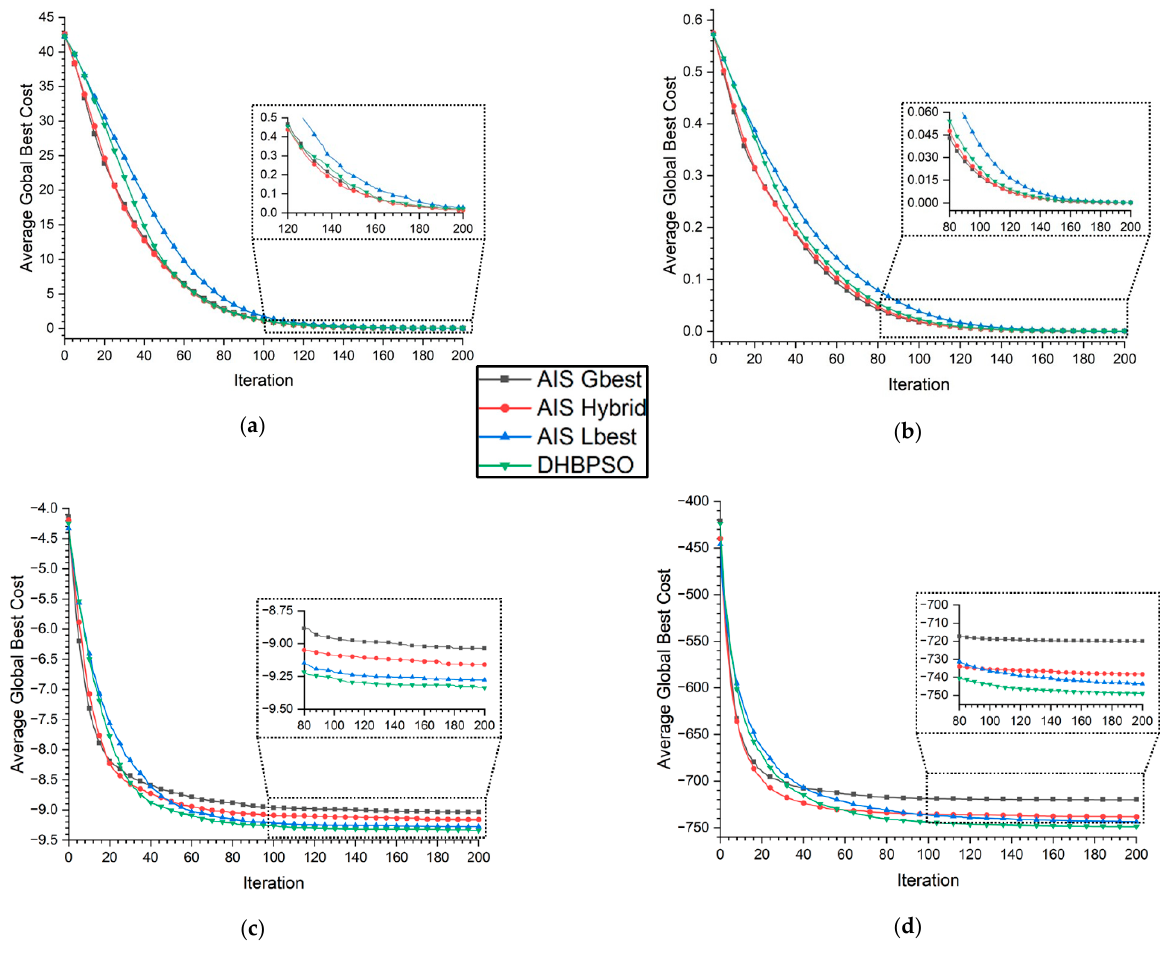
Figure 2. Convergence traces of various BPSO algorithms while optimizing ( a ) Sphere, ( b ) Griewank, ( c ) Holder Table 2, and ( d ) Eggholder functions showing global best output over 200 iterations, averaged over 500 runs .